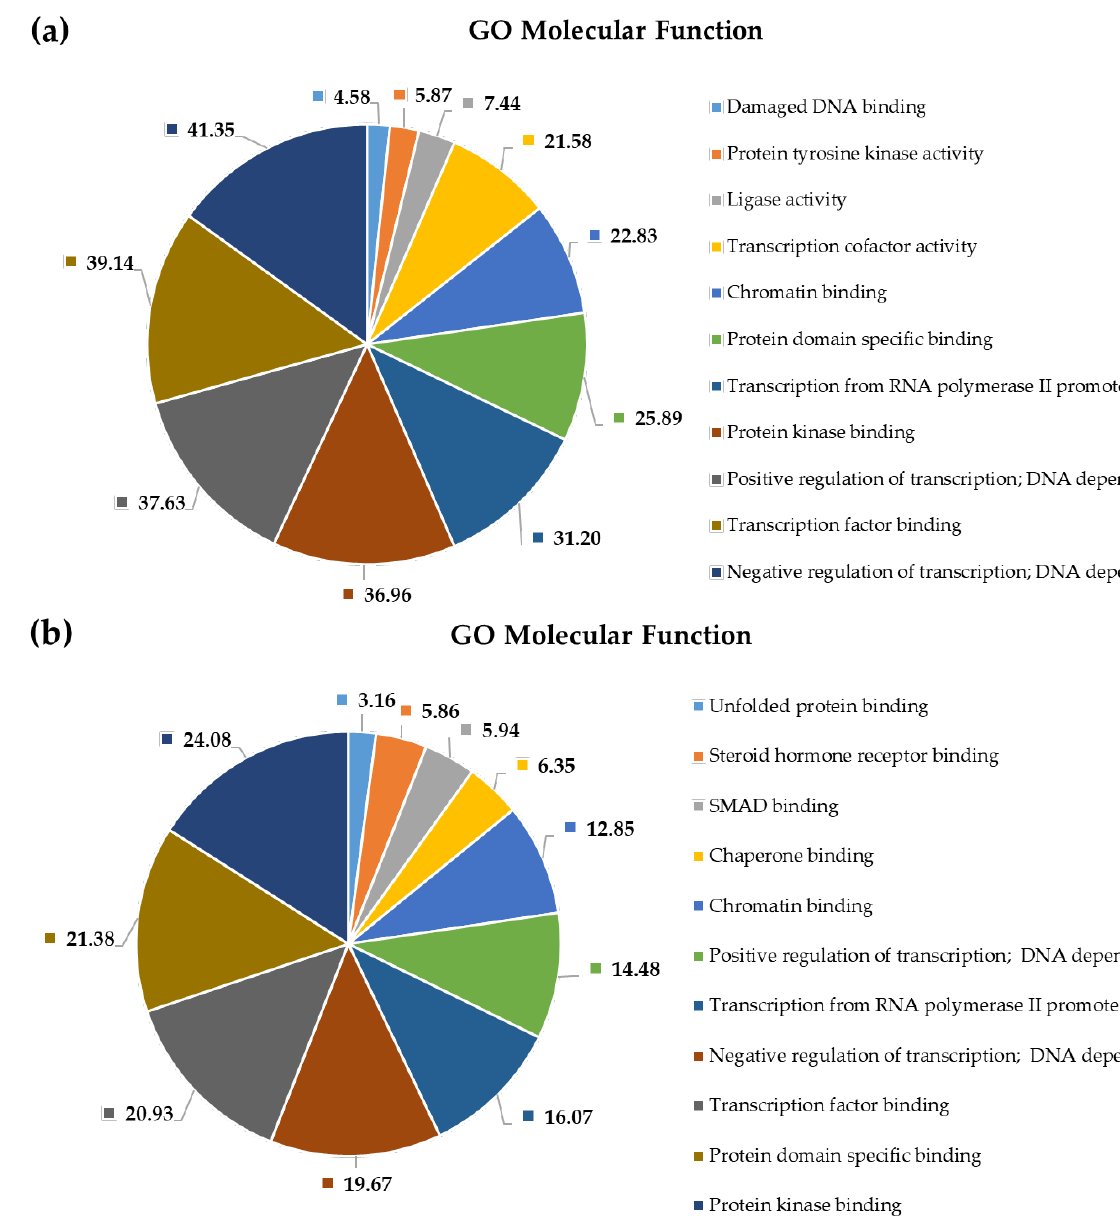
Figure 8. GO biological process – based general ( a ) and cortex-specific ( b ) functional enrichment annotation of all target genes of differentially expressed miRNAs applying the NetworkAnalyst tool. Significance of the selected (?) pathways are characterized by their FDR values shown inside the chart sections.